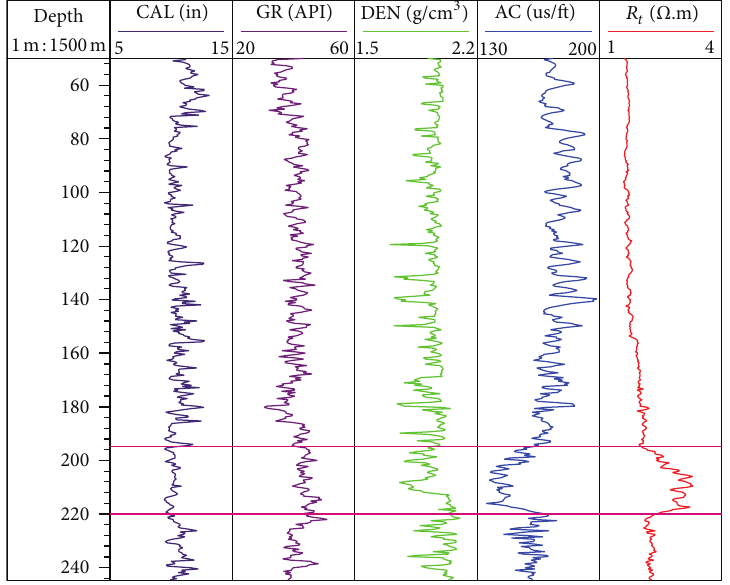
Figure 2: The conventional logs in site SH2 [10]. (The area delineated by a pink line is the occurrence of gas hydrate reservoir, and the depth range is 195 to 220